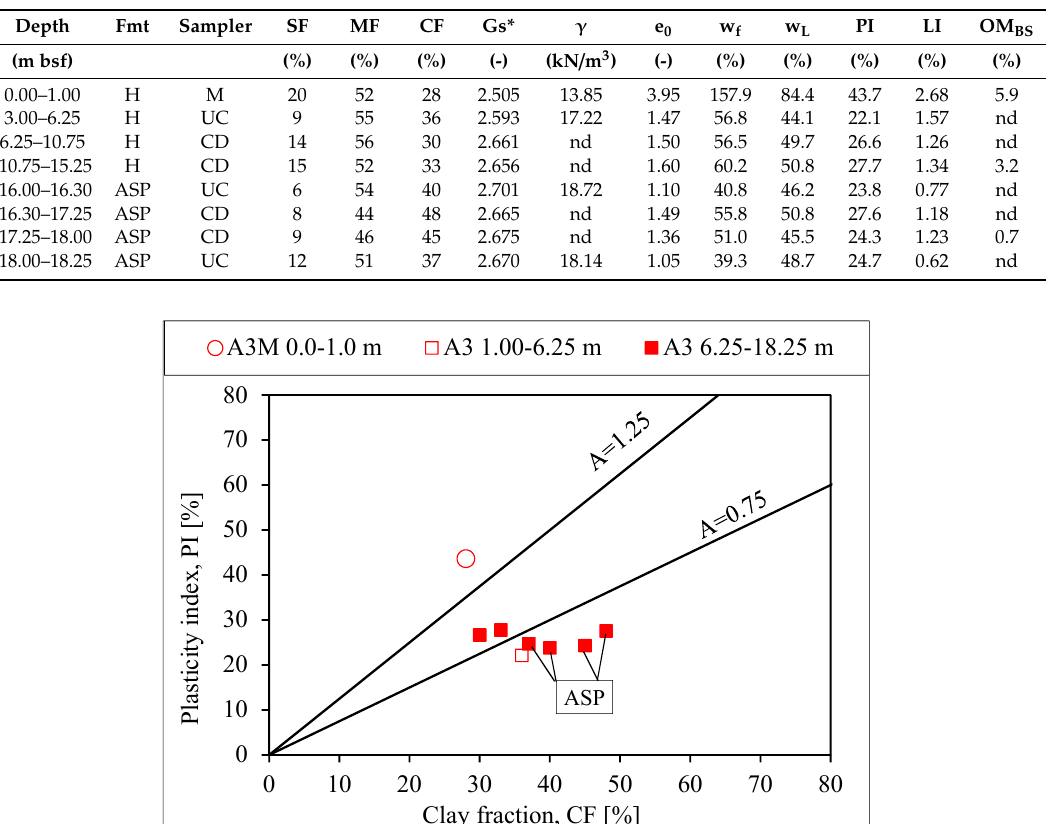
Figure 5. Activity chart of sediments from borehole A3 collected from Holocene (H) to Sub-Apennine clays (ASP) formations.